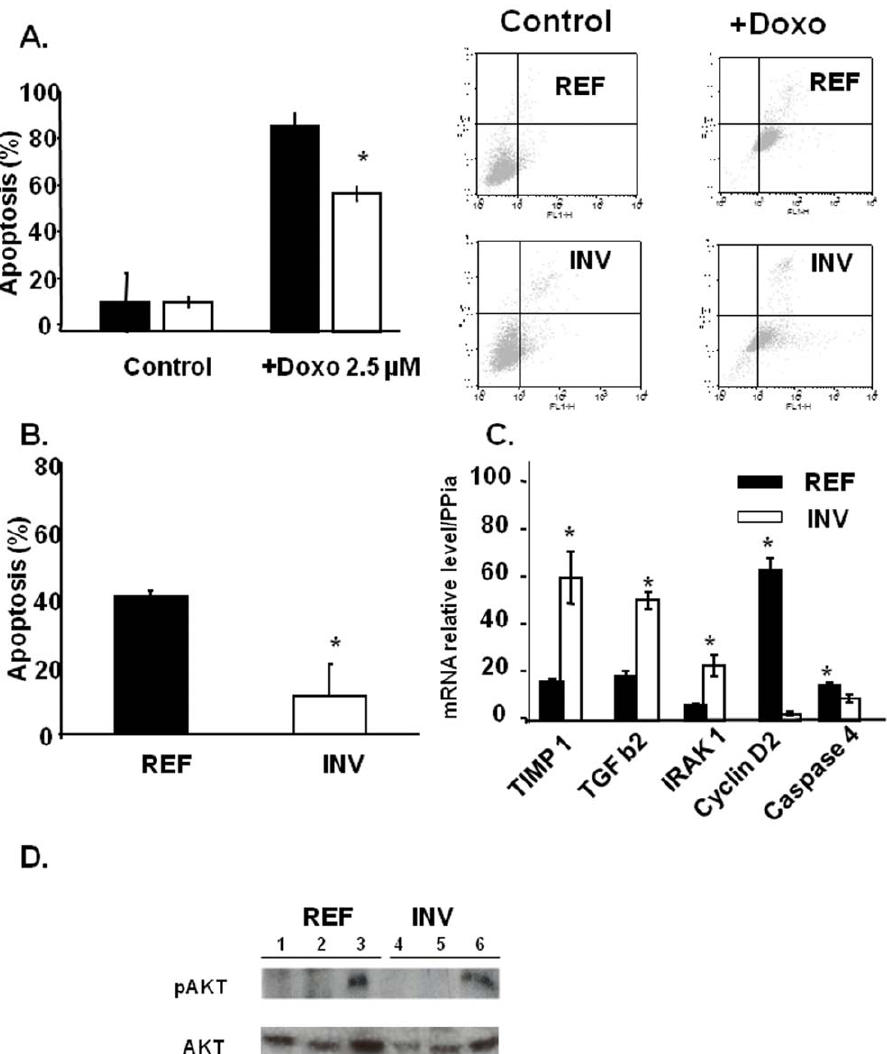
Figure 5. REF and INV cell death. Cells (2 6 10 5 ) were cultured for 96 h in serum-free medium or were incubated with 2.5 m M Doxorubicin for 72 h in a serum-containing medium (A) or were cultured for 96 h in serum-free medium (B). For qRT-PCR analysis (C), total RNA (1 m g) was reverse- transcribed and the results were normalized as described above. (D) REF cells (Lanes 1 to 3) and INV cells (lanes 4 to 6) were treated (lane 1 and 4) with Serum free DMEM for 1 h or for 3 days (lanes 2 and 5) or with 10 ng/ml of IGF-1 (lanes 3 and 6), to detected AKT and pAKT by western blotting. Each column shows means ( 6 SD) of three independent experiments. * P , 0.05.